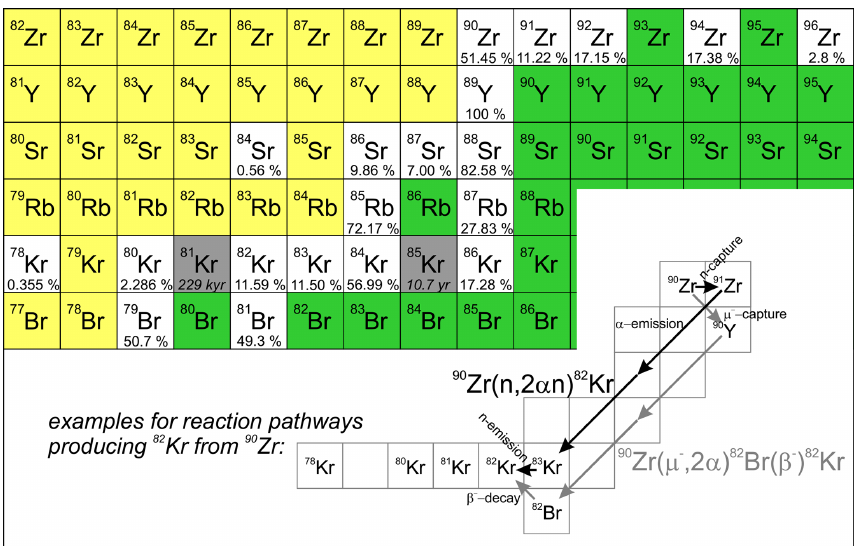
Figure 2. Excerpt of the nuclide chart of the region relevant for spallogenic and muogenic production of cosmogenic Krypton from its main target elements (Rb, Sr, Y and Zr; Gilabert et al., 2002; Marti, 1967). Stable isotopes (and isotopes with half-lives > 1Gyr; white) are shown with their natural abundance (in %; Soppera et al., 2014). The long-lived nuclides 81 Kr and 85 Kr nuclides (i.e. half-lives > 1 year, grey) are shown with their half-lives (Soppera et al., 2014). Nuclides to the left of the field of stable nuclides (yellow) decay via β + (positron) emission or electron capture; nuclides to the right of the stable nuclides (green) decay via β − (electron) emission from their nuclei. For illustration of how to “read” the chart for nuclear reactions, examples for reactions producing 82 Kr from 90 Zr are shown at the bottom of the